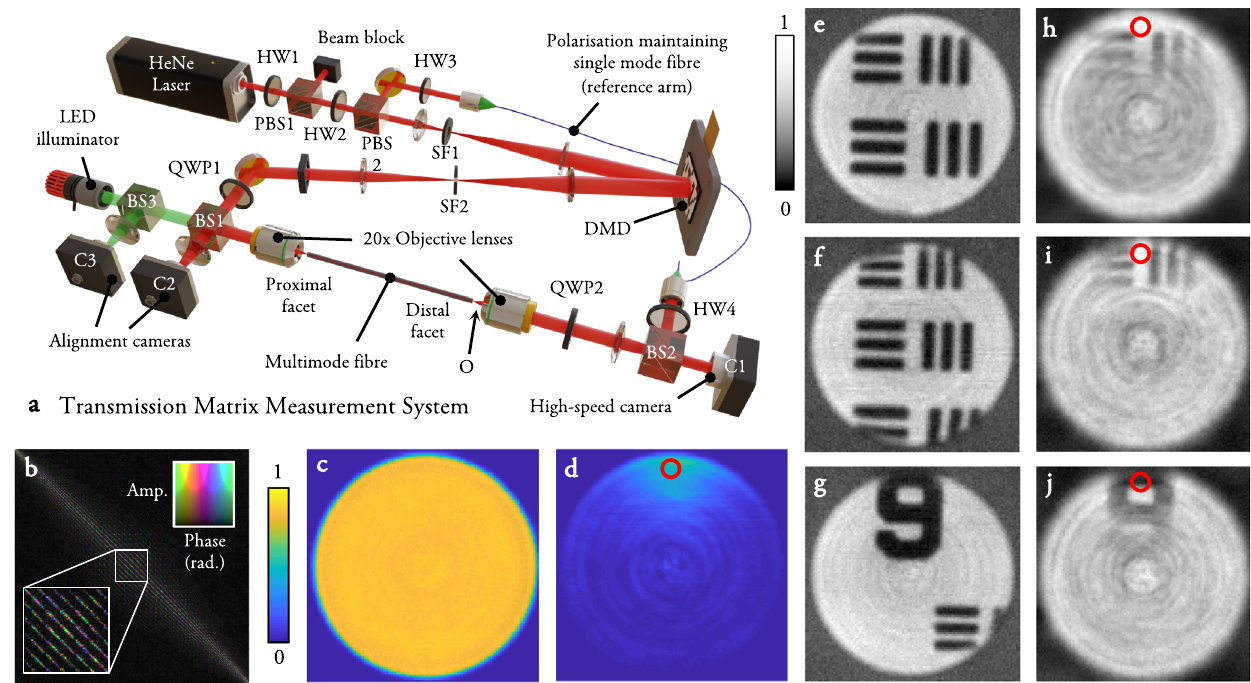
Fig. 4 Proof of principle experiments. a Experimental set-up to measure the full TM of an MMF, emulate ATM measurement with a guide-star, and image through the MMF using the full TM and ATM. HW half wave-plate, QW quarter wave-plate, BS beamsplitter, PBS polarising beamsplitter, SF spatial fi